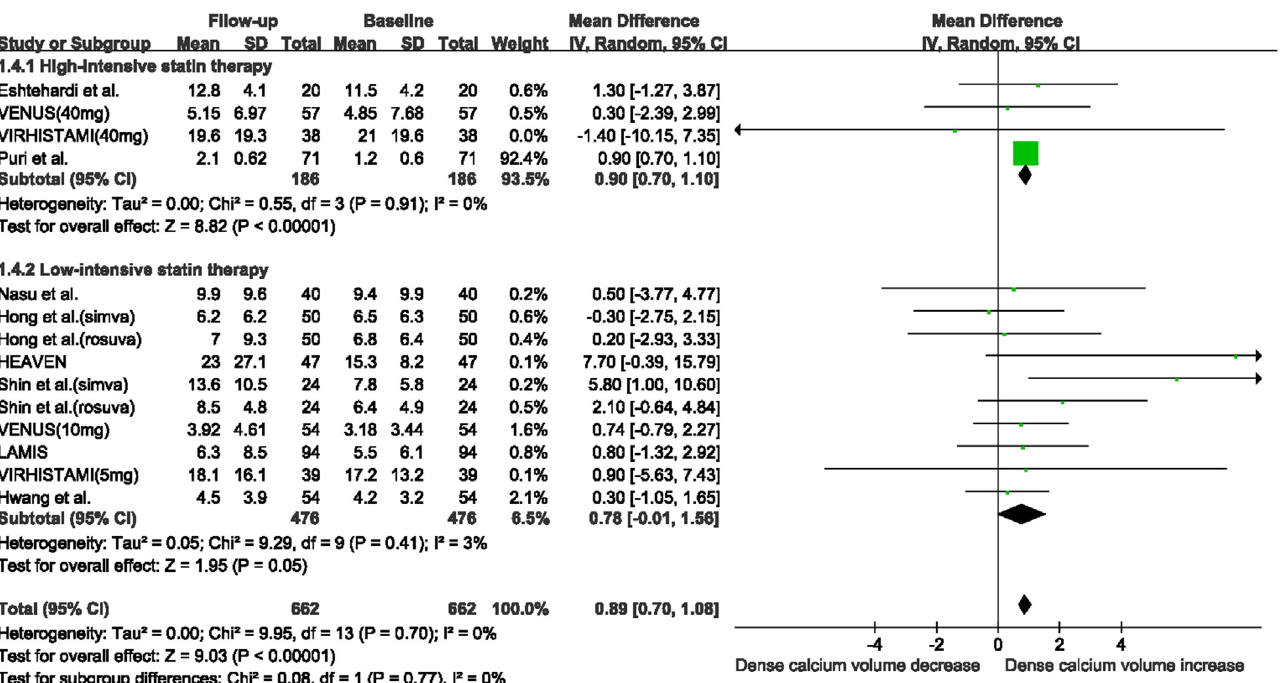
Fig 7. Meta-analysis of changes in dense calcium volume with statin therapy using stratified analysis based on the intensity of statin therapy. Abbreviations: CI: confidence interval; SD: standard deviation.